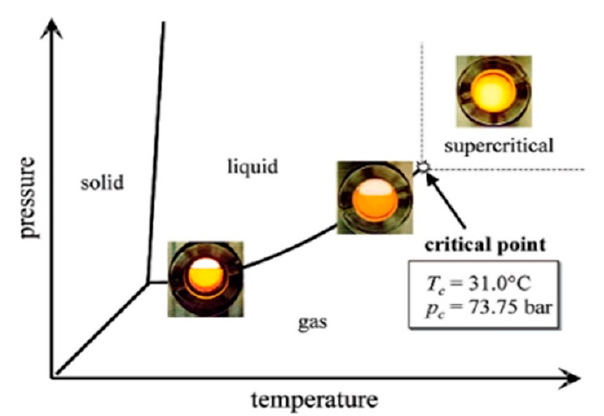
Figure 1. A brilliant orange CO 2 -philic complex of rhodium was added in order to obtain better contrast and to demonstrate the solvent behavior of the liquid and the supercritical phase in the CO 2 phase diagram, which is illustrated with figures of the transition from the liquid/gas region to the supercritical region [11] .